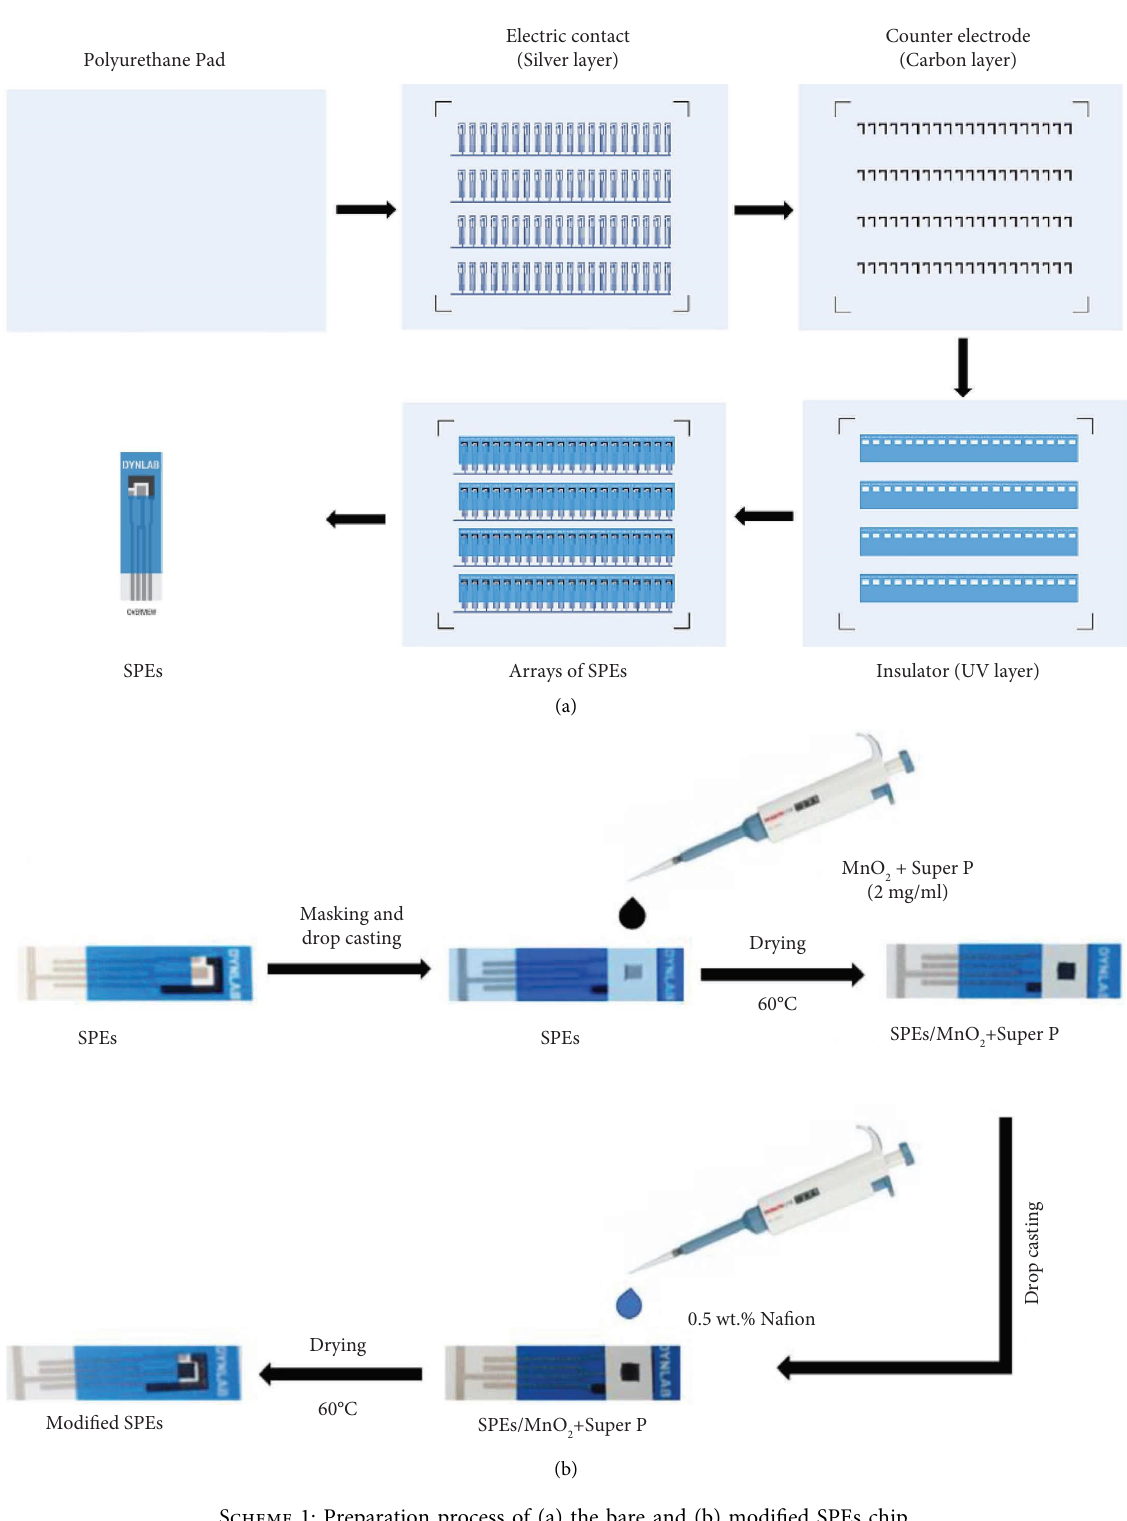
Scheme 1: Preparation process of (a) the bare and (b) modifed SPEs